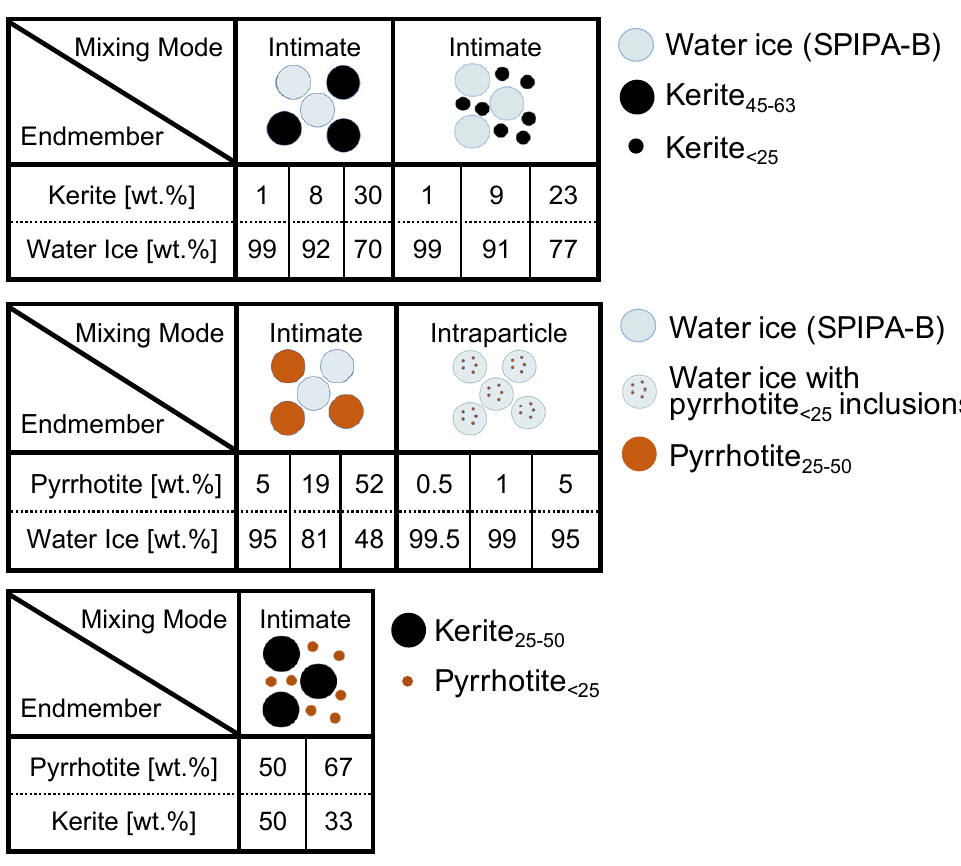
Figure 2. Set of binary mixtures investigated in this work. Top panel: water ice–kerite mixtures; central panel: water ice–pyrrhotite mixtures; bottom panel: kerite–pyrrhotite mixtures. See text for further